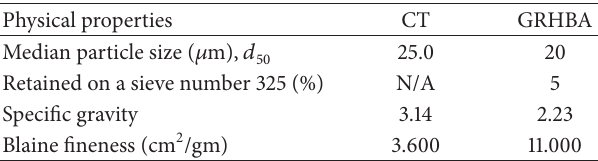
Table 1: The mechanical properties of cement and pozzolanic materials.